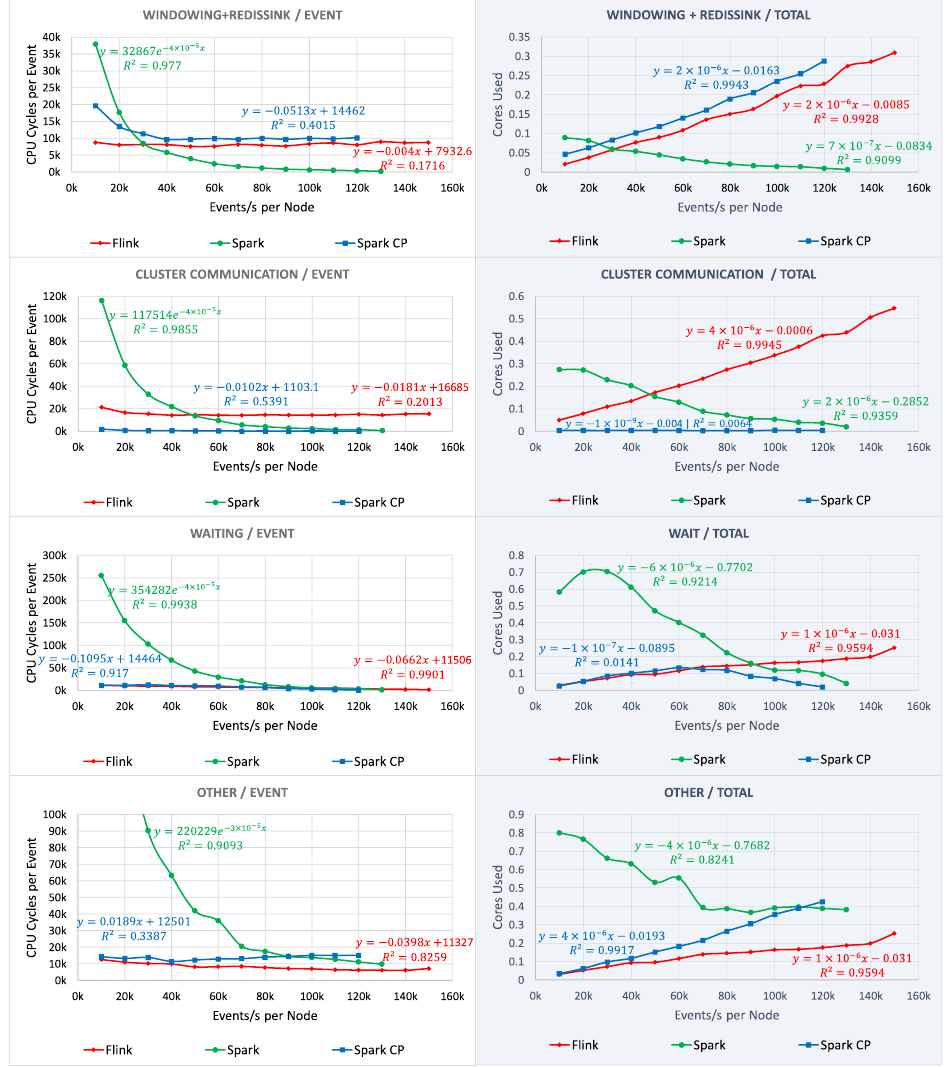
Figure 8. CPU consumption per task when scaling the